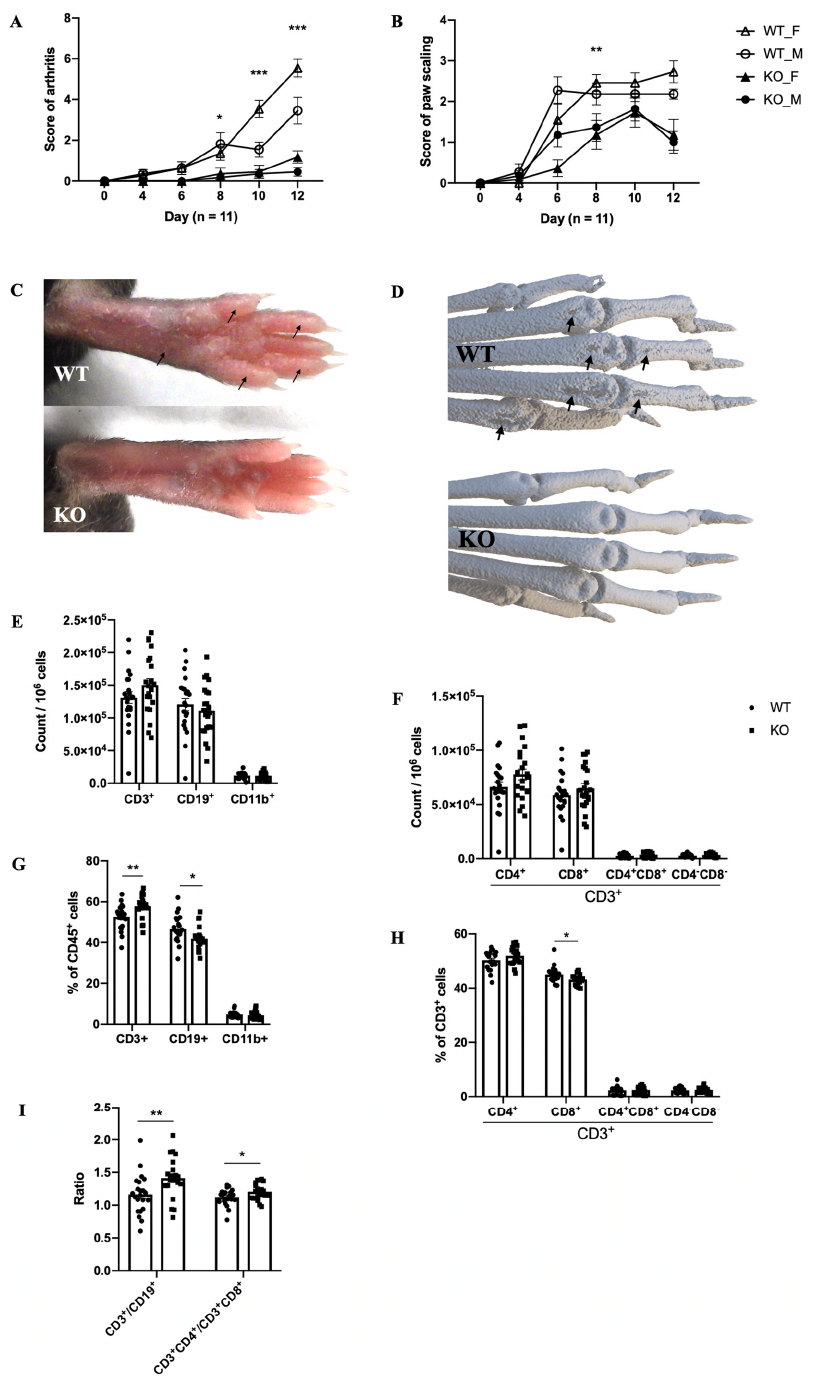
Figure 2. Reduced susceptibility of Pla1a − / − mice to MIP disease. Age- and sex-matched mice were i.p. injected with 20 mg mannan on days 0, 4, and 8. Mice were evaluated on day 0 and every two days after day 4. Mice were euthanized on day 12. ( A , B ) Score of arthritis and paw scaling in males and females ( n = 11 per group). ( C , D ) Representative images of sick hind paws and µ CT scans (female) on day 12 after injection of mannan. Peeling, edema, and bone erosions were marked (arrows). The next figures combined data from males and females ( n = 22 per group). ( E , F ) Quantification of immune cell populations in the lymph nodes. ( G , H ) Percentage of immune cell populations in the lymph nodes quantified by flow cytometry. ( I ) Ratio of assigned cell populations. For statistical comparative analyses in ( A , B ), we performed a multivariate analysis of the variance (MANOVA). *, p < 0.05; **, p < 0.01; ***, p < 0.001; unnoted, p >